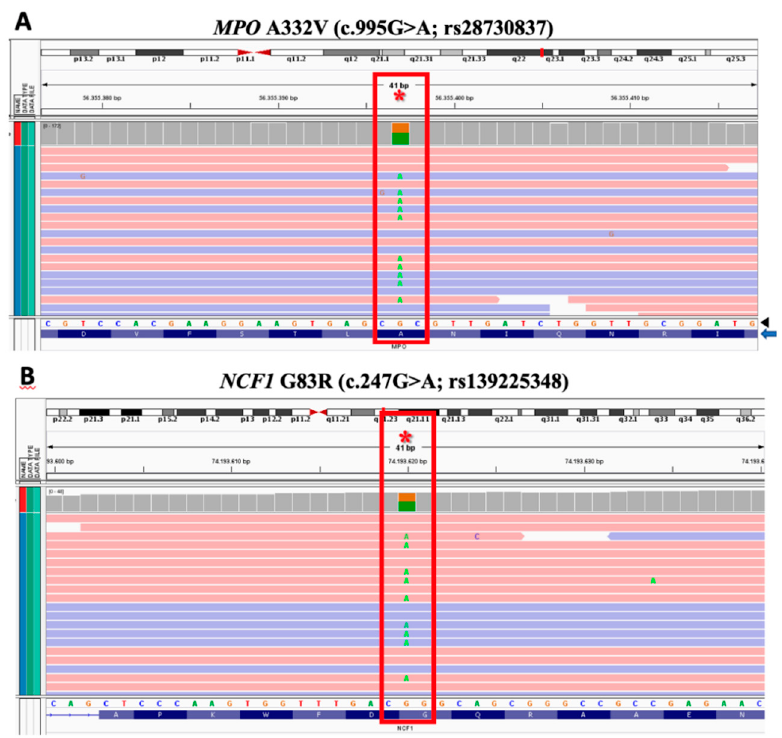
Figure 3. Whole exome sequencing alignment showing oxidative burst-related candidate heterozygous gene variants (red star): ( A ) MPO A332V (c.995G > A; rs28730837) and ( B ) NCF1 G83R (c.247G > A; rs139225348). Green: heterozygous switched base pair (approximately half of acquisition readouts); right bottom panel arrowhead: expected DNA sequence; right bottom panel blue arrow: expected amino acid sequence.